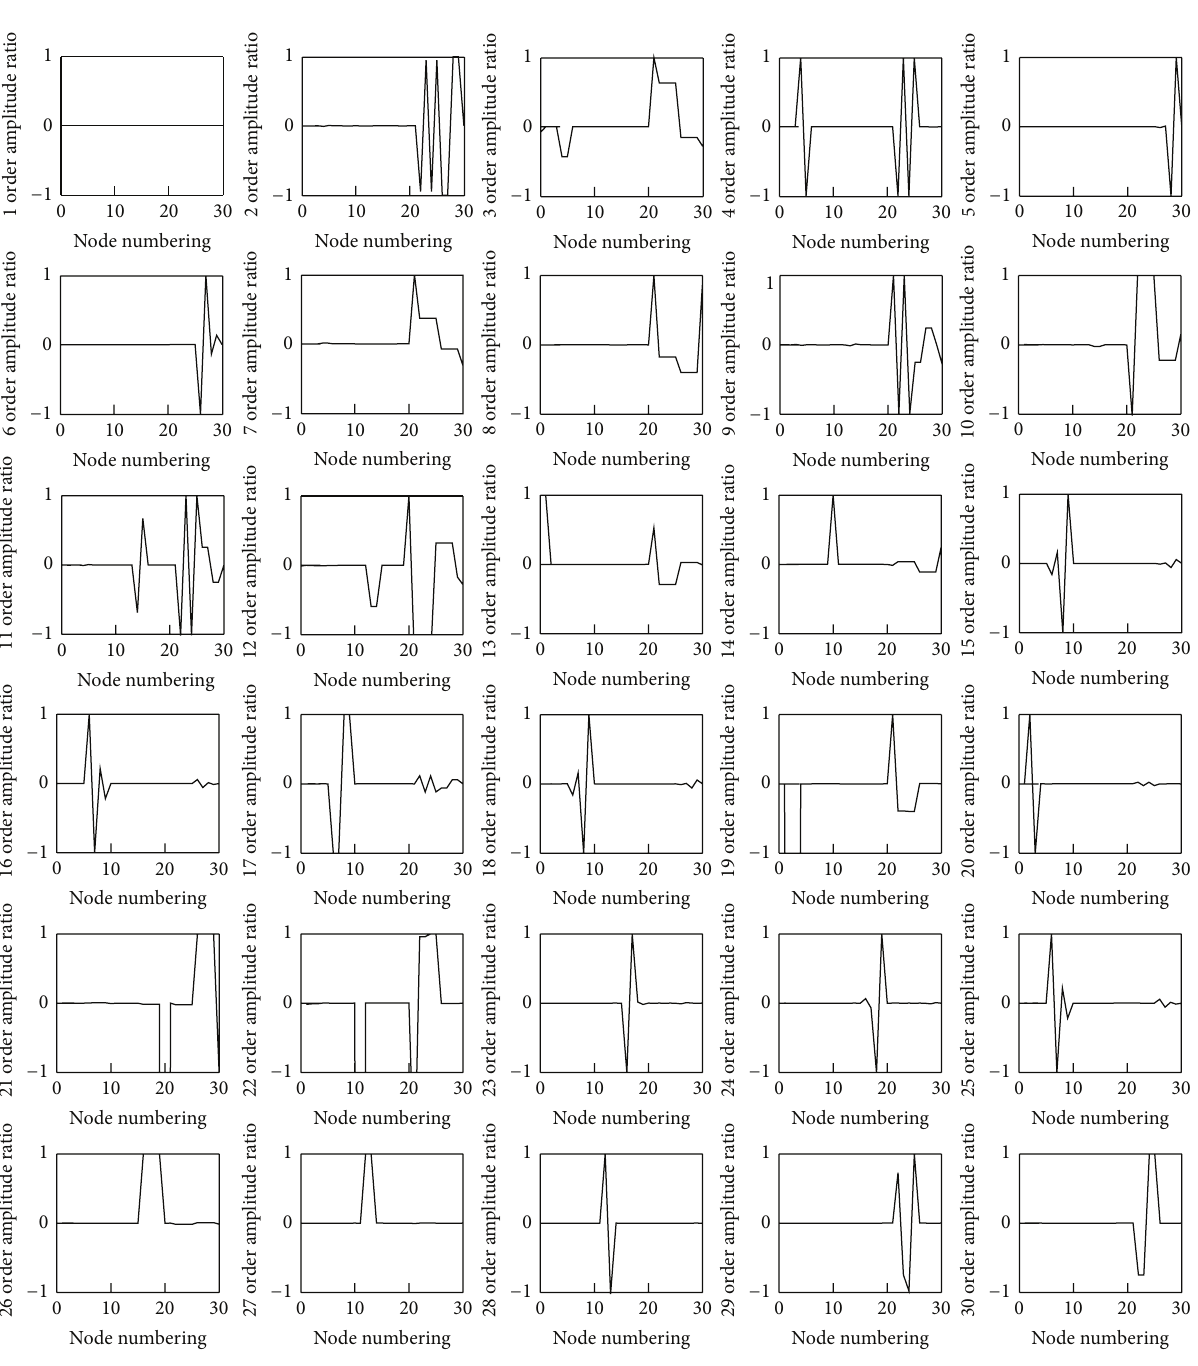
Figure 8: Each natural principal mode of